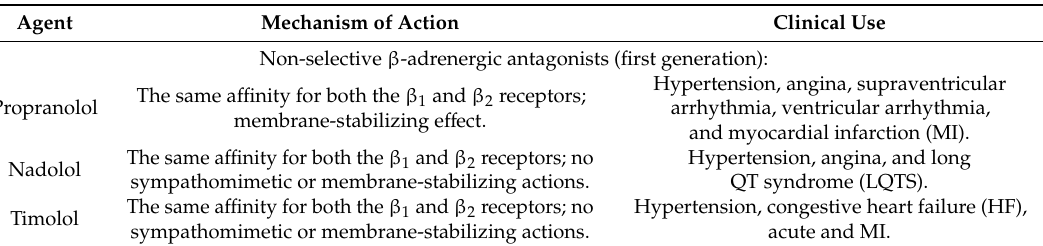
Table 1. Beta-blocker agents used